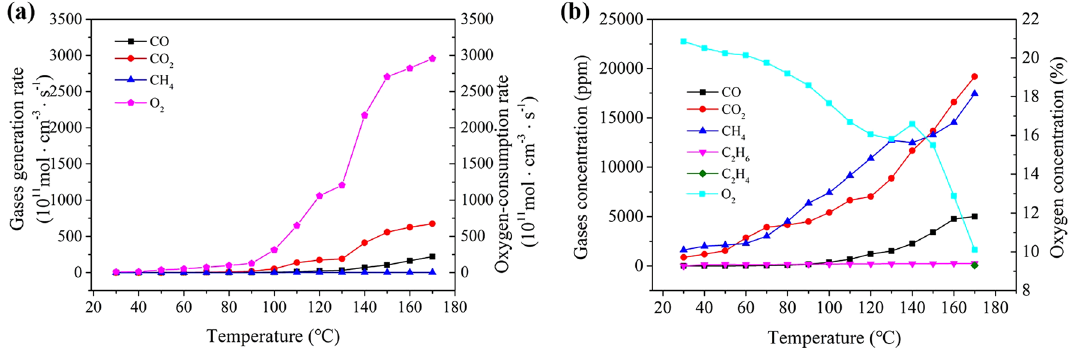
Figure 5. Results from TPO experiments ( a oxygen consumption and gas generation rates; b concentrations of oxygen and gases concentration). Spectral peak